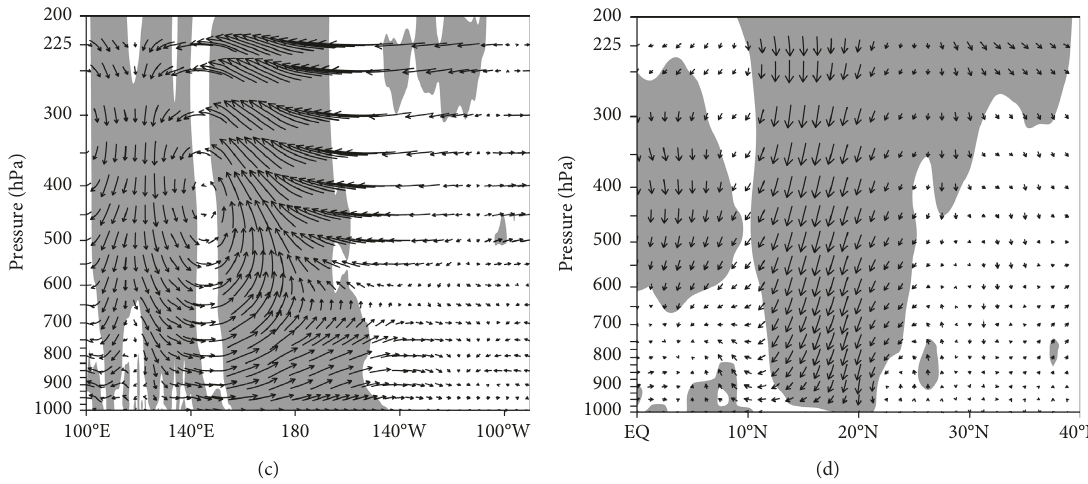
Figure 9: The regression of meteorological elements on the EMI index: (a), (b), (c), and (d) same as (a), (b), (c), and (d) in Figure 6. (a) 850hPa wind regression on EMI. (b) Water vapor flux regression on EMI. (c) u ; w on EMI. Table 2: The area average of related to EMI index 850hPa regression anomaly of B 1– B 7 and C 1– C 6 over SEC (unit: 10 − 19 m B 1